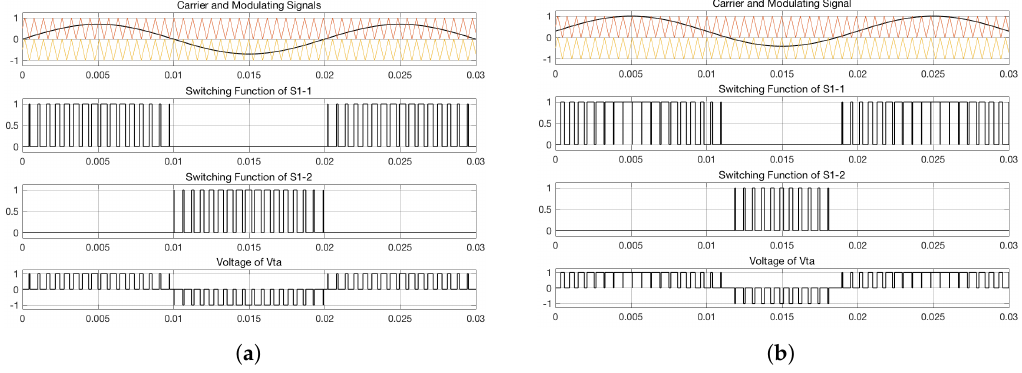
Figure 4. Comparison of symmetrical and asymmetrical modulating signal. ( a ) symmetrical signal; ( b ) signal with direct